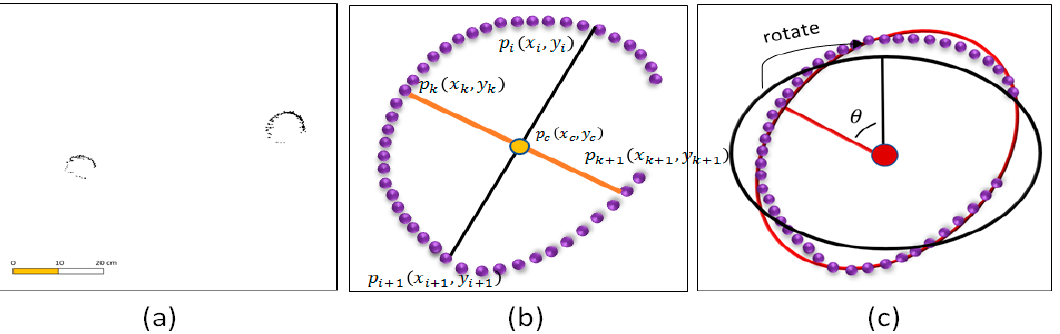
Figure 4. Mathematical processes for determining the optimal fitting circle in amelioration; ( a ) example of non-ideal points; ( b ) the determination of the long and short axes of the fitted ellipse; ( c ) determination of the rotation angle of the fitted ellipse.